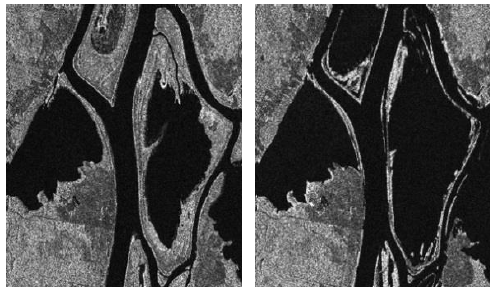
Figure 3. Original image and change detection map in Ottawa area.